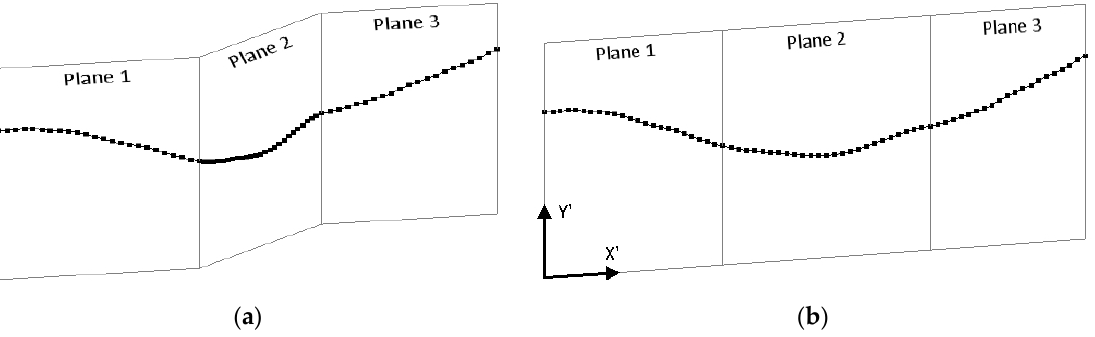
Figure 25. ( a ) Three planes of the three-dimensional cross-section and ( b ) a single unfolded plane of the two-dimensional cross-section. The coordinate system Χ ’-Y’ appears in the lower left corner.